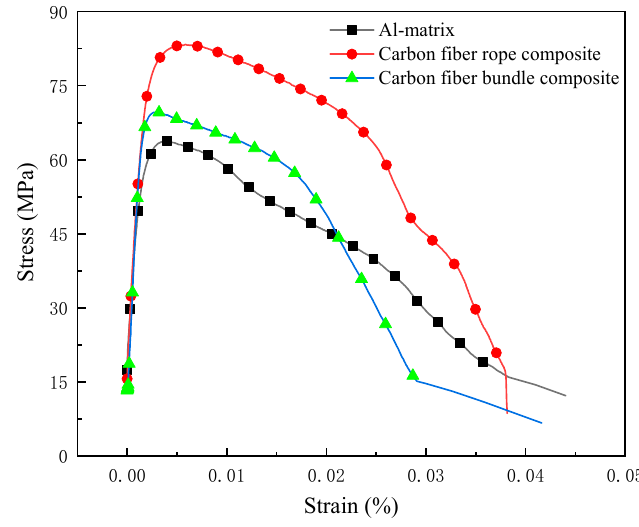
Figure 11. Results of mechanical properties test of composite materials.